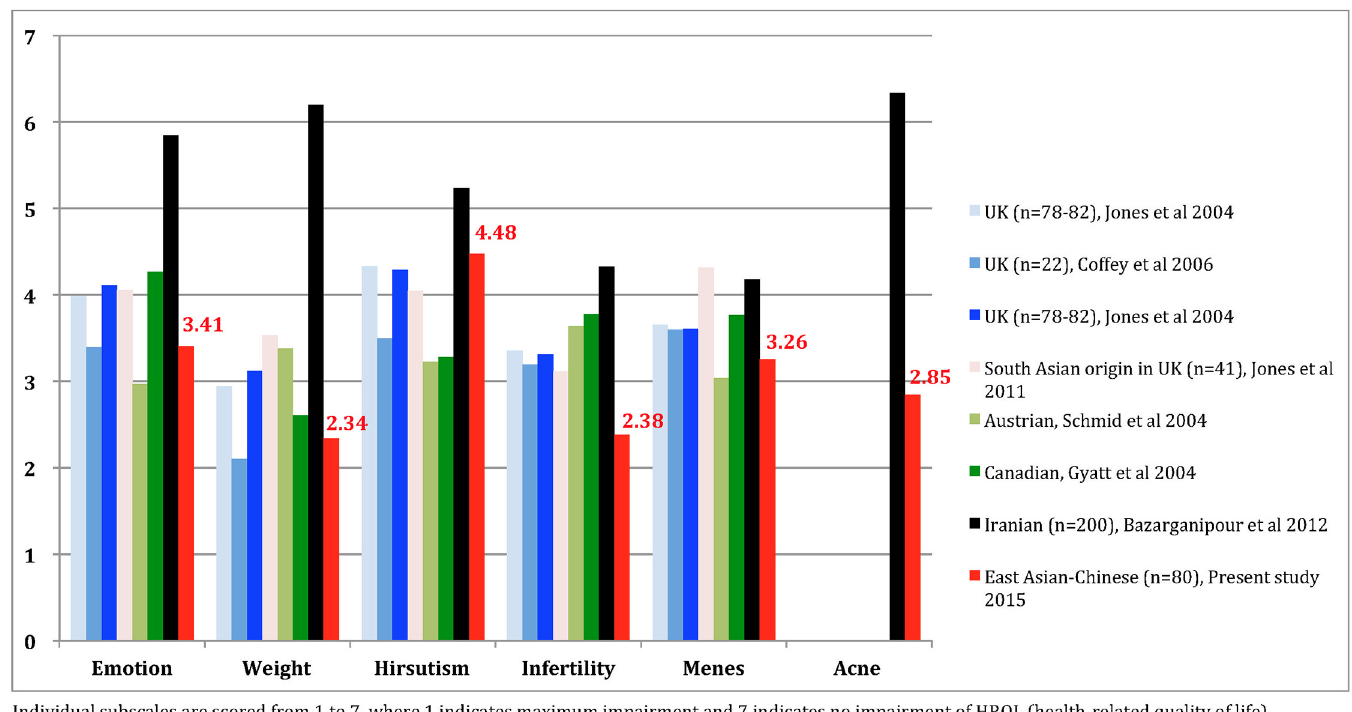
Fig 1. Comparisons across ethnicities in HRQoL of PCOS women measured using